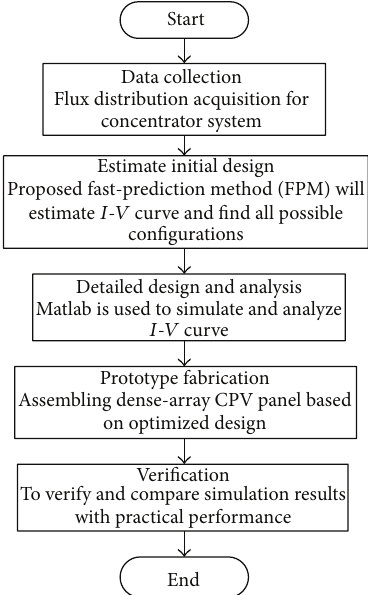
Figure 1: An algorithm to show systematic and complete approach in achieving high-performance dense-array using a newly proposed fast prediction method (FPM) at the second process, which is initial design